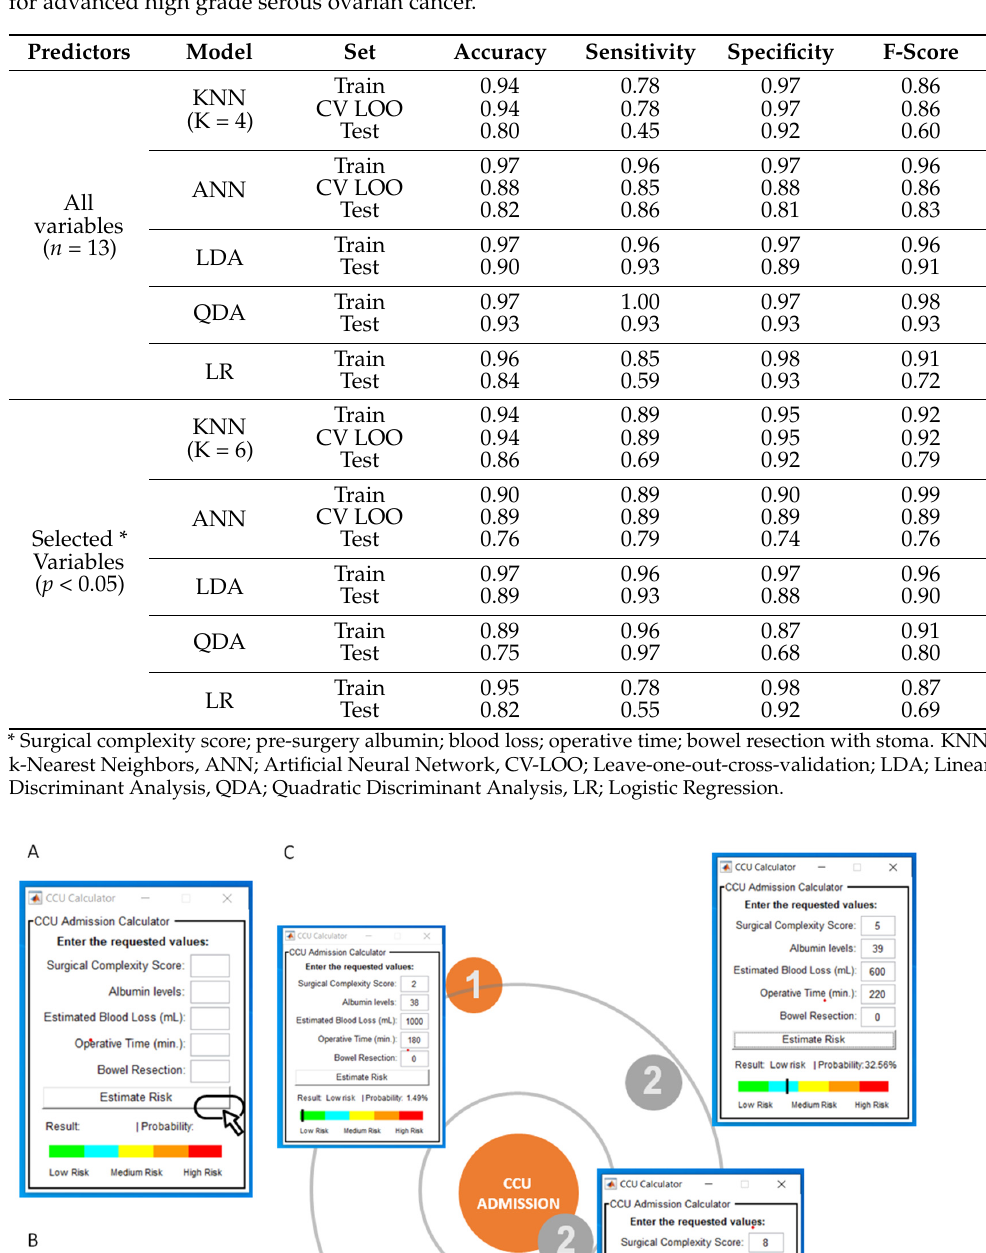
Table 2. Performance metrics of the Machine Learning models and comparisons with conventional Logistic Regression for the prediction of Critical Care Unit admission following cytoreductive surgery for advanced high grade serous ovarian cancer.